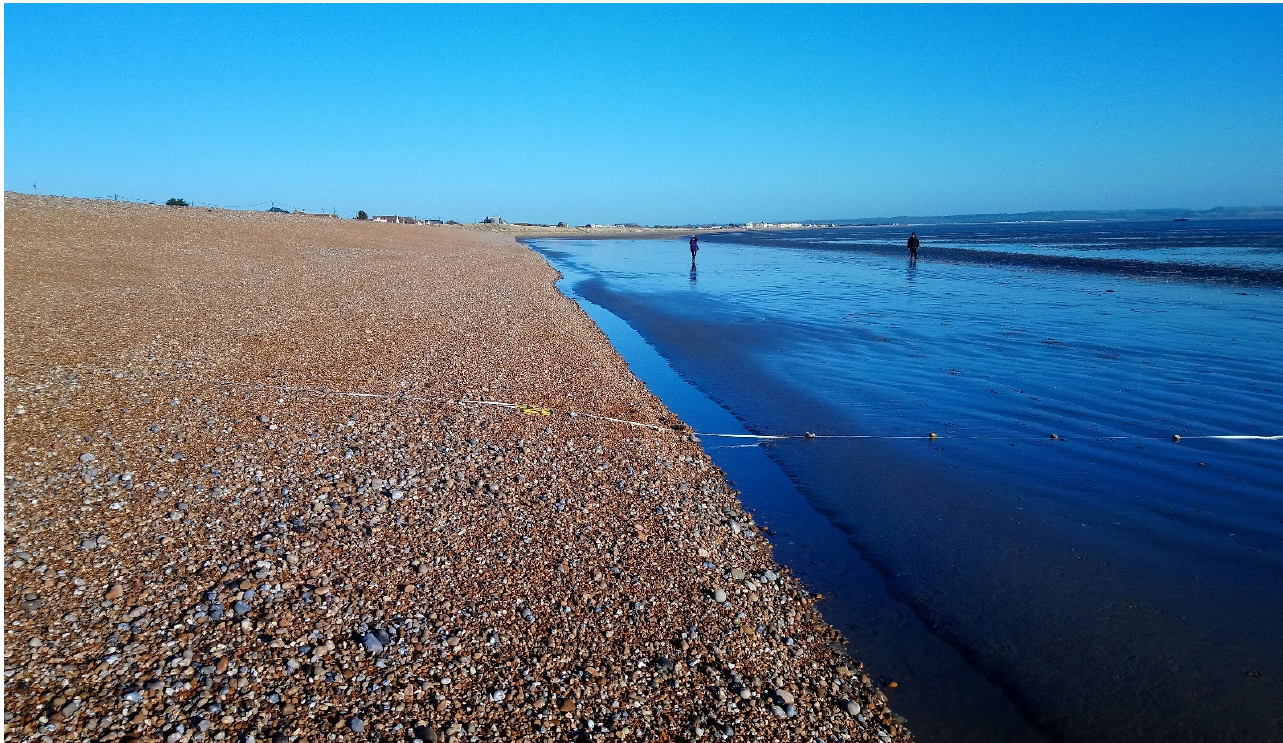
Figure 2. Field photograph of shingle sand contact on the beach at Dungeness. Note the sharp nature of the contact, the contrast in tone between darker sand and pale shingle that can be distinguished on aerial images and used to map historic ‘shorelines,’ as well as the break in slope between the steeper shingle beach and lower angle intertidal sands. The steeply dipping beachface is visible on GPR profiles.